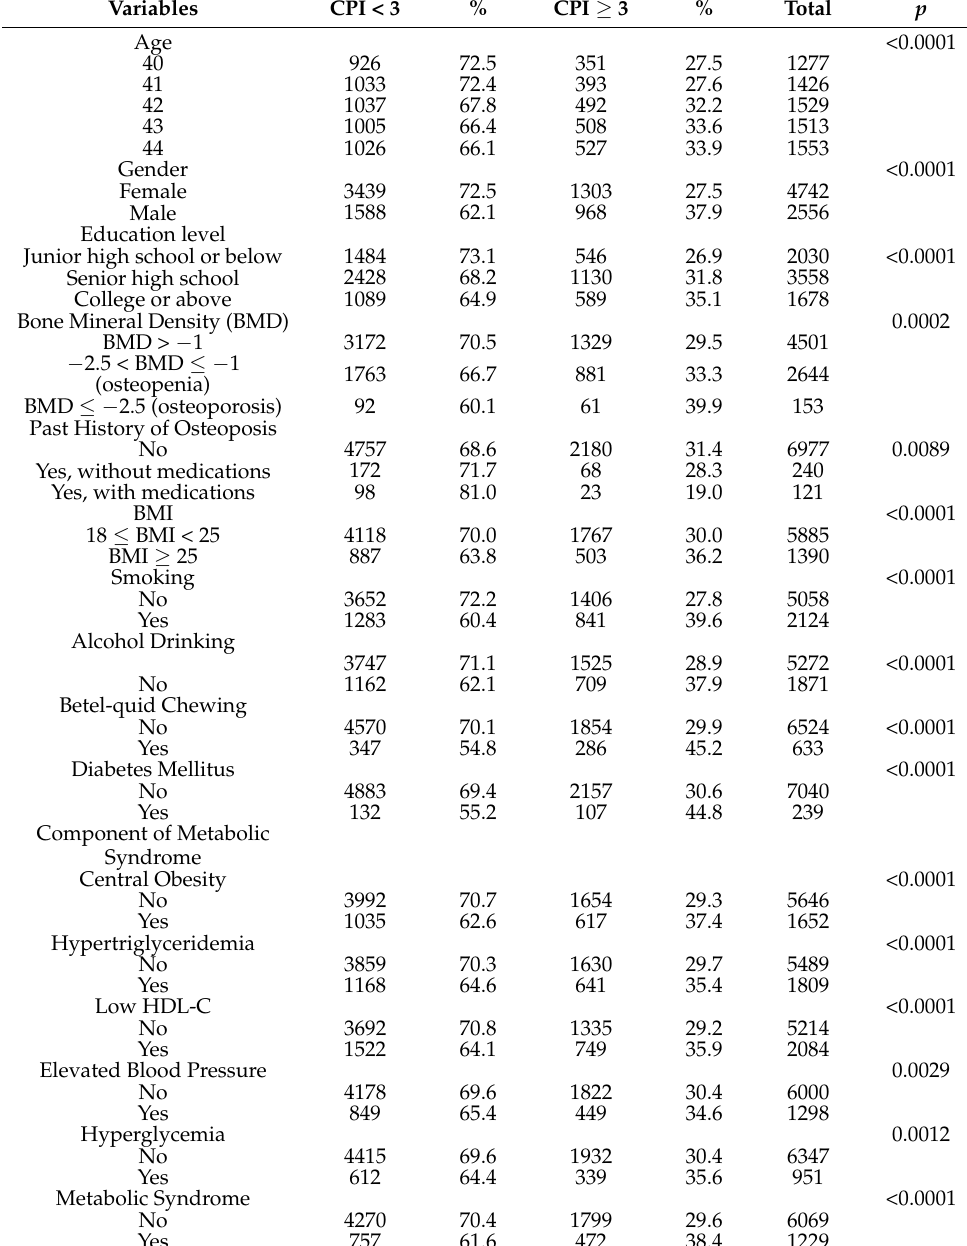
Table 1. Baseline characteristics of study subjects.